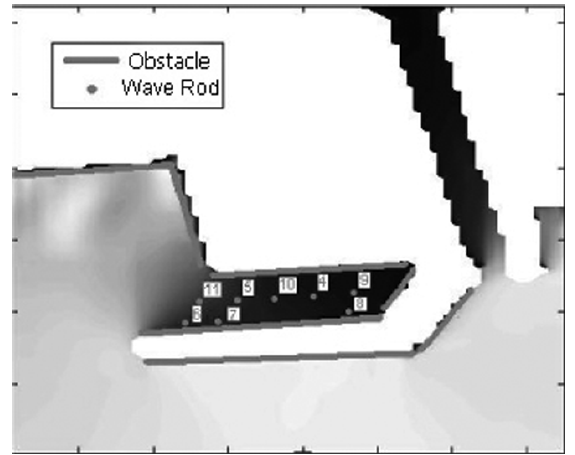
Fig. 2 – Obstacle lines represented by the dark gray lines around the Port of CST, where reflection is computed by the SWAN model. The position of the wave rods in the computational domain is also shown, which are the grid points where significant wave height were estimated by the numerical models. The figure represents the region between latitudes 20 ◦ 15 0 35 00 S and 20 ◦ 15 0 47 00 S and longitudes 40 ◦ 13 0 21 00 W and 40 ◦ 13 0 01 00